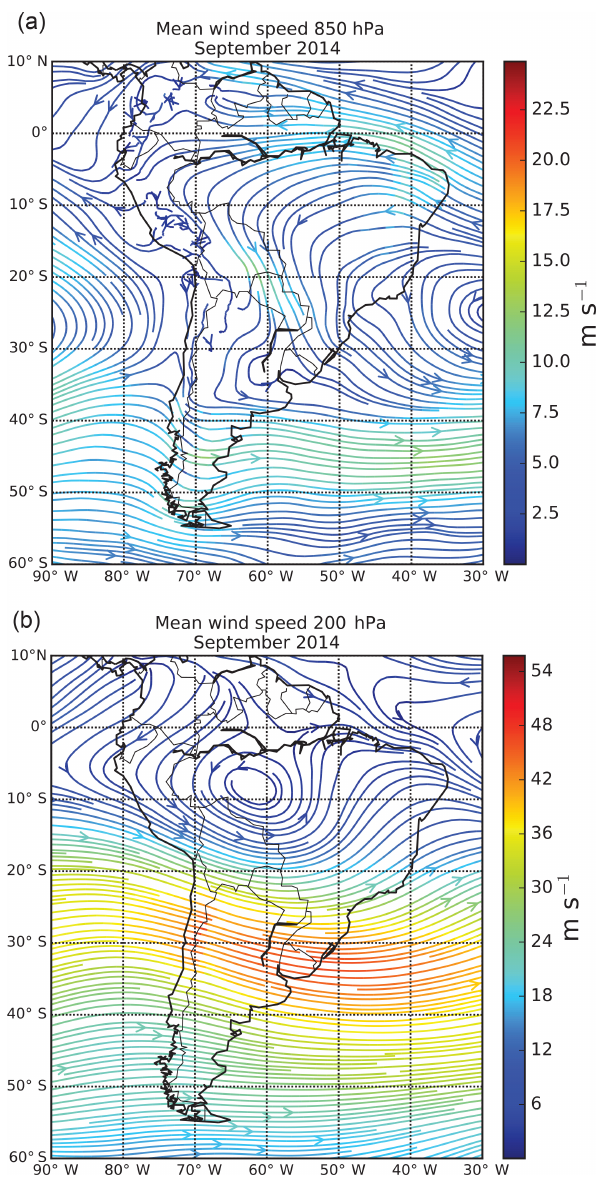
Figure 4. Mean wind speeds during September 2014 at (a) 850hPa and (b) 200hPa (data from